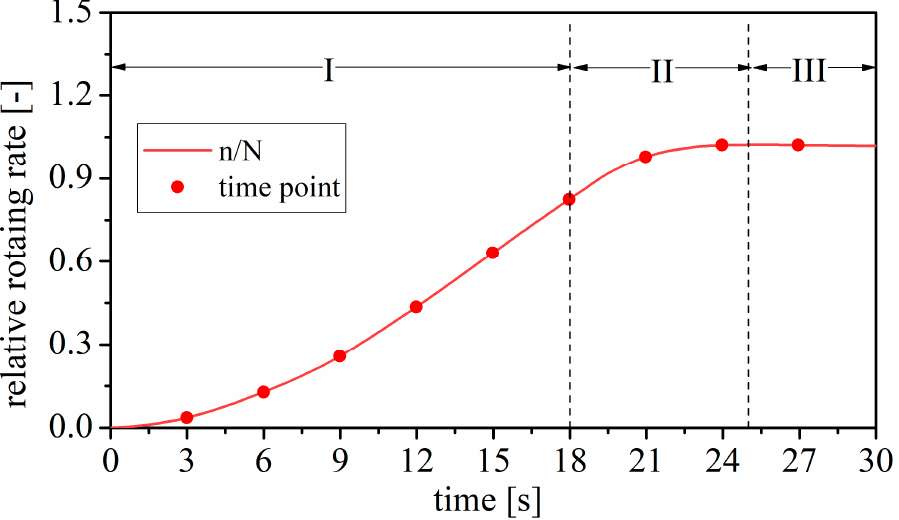
Figure 9. The variation of rotating rate (n/N).